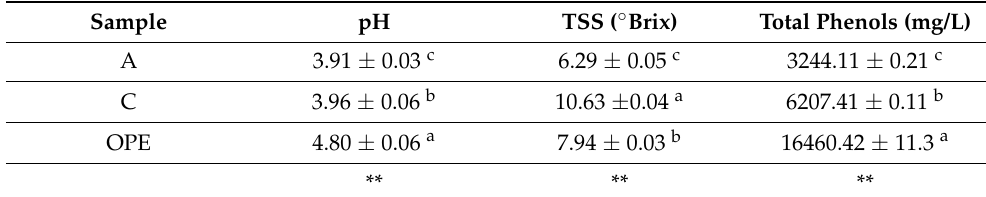
Table 1. Chemical characterisation of the three tested OMWW fractions.